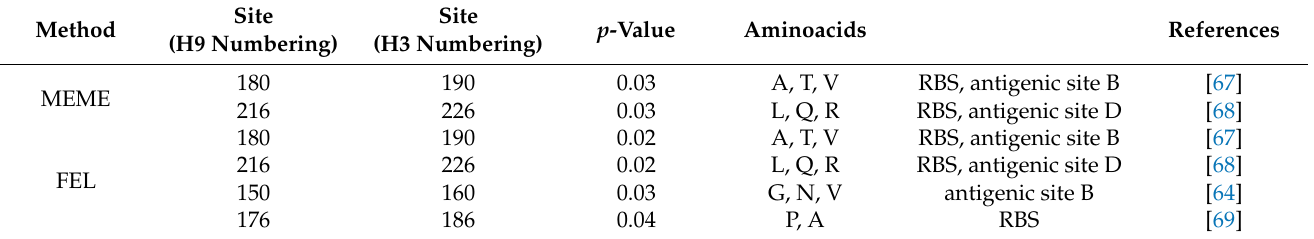
Table 2. Sites under positive selection ( p -value < 0.05) in the Moroccan H9N2 viruses HA protein.